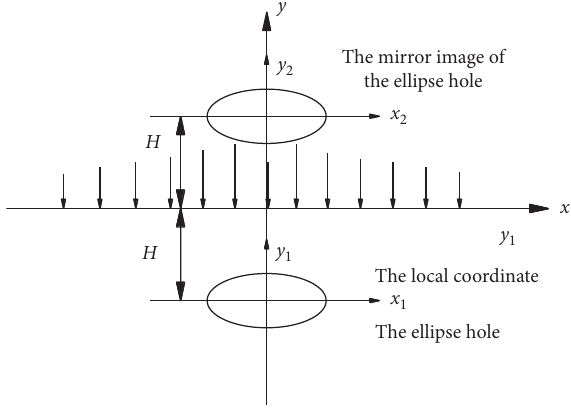
Figure 9: Diagram of the virtual image technique.